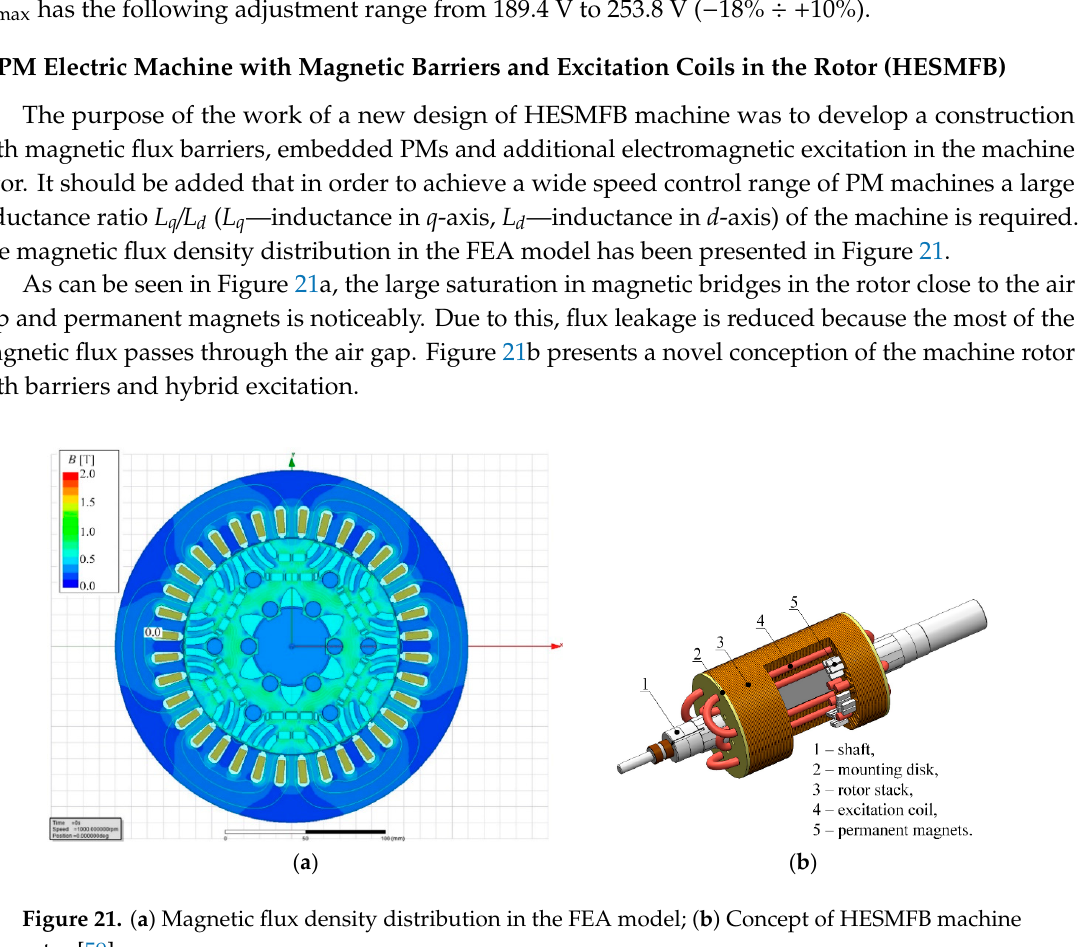
Figure 20. ( a ) Maximum value of the cogging torque depending on the current in the excitation coil; ( b ) Distribution of the back-EMF depending on the current in the excitation coil [58].